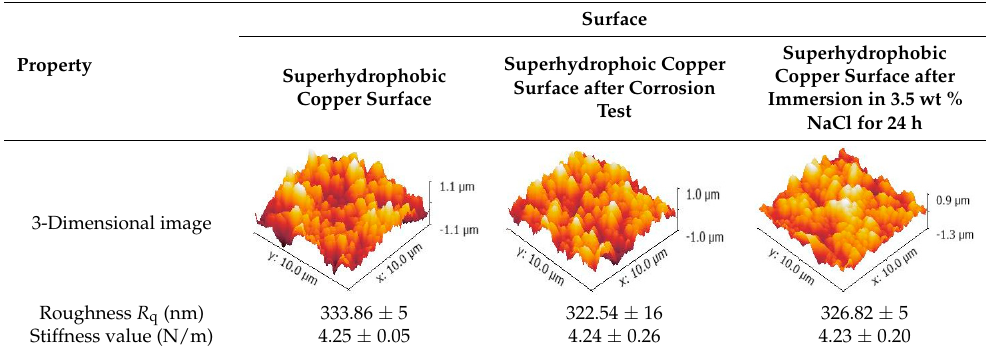
Figure 8. Static contact angle: ( a ) before ultrasonication and ( b ) after ultrasonication in water; Static contact angle ( c ) before ultrasonication and ( d ) after ultrasonication in 3.5 wt % NaCl solution. Table 2. AFM image, roughness, and stiffness of the superhydrophobic copper surfaces.